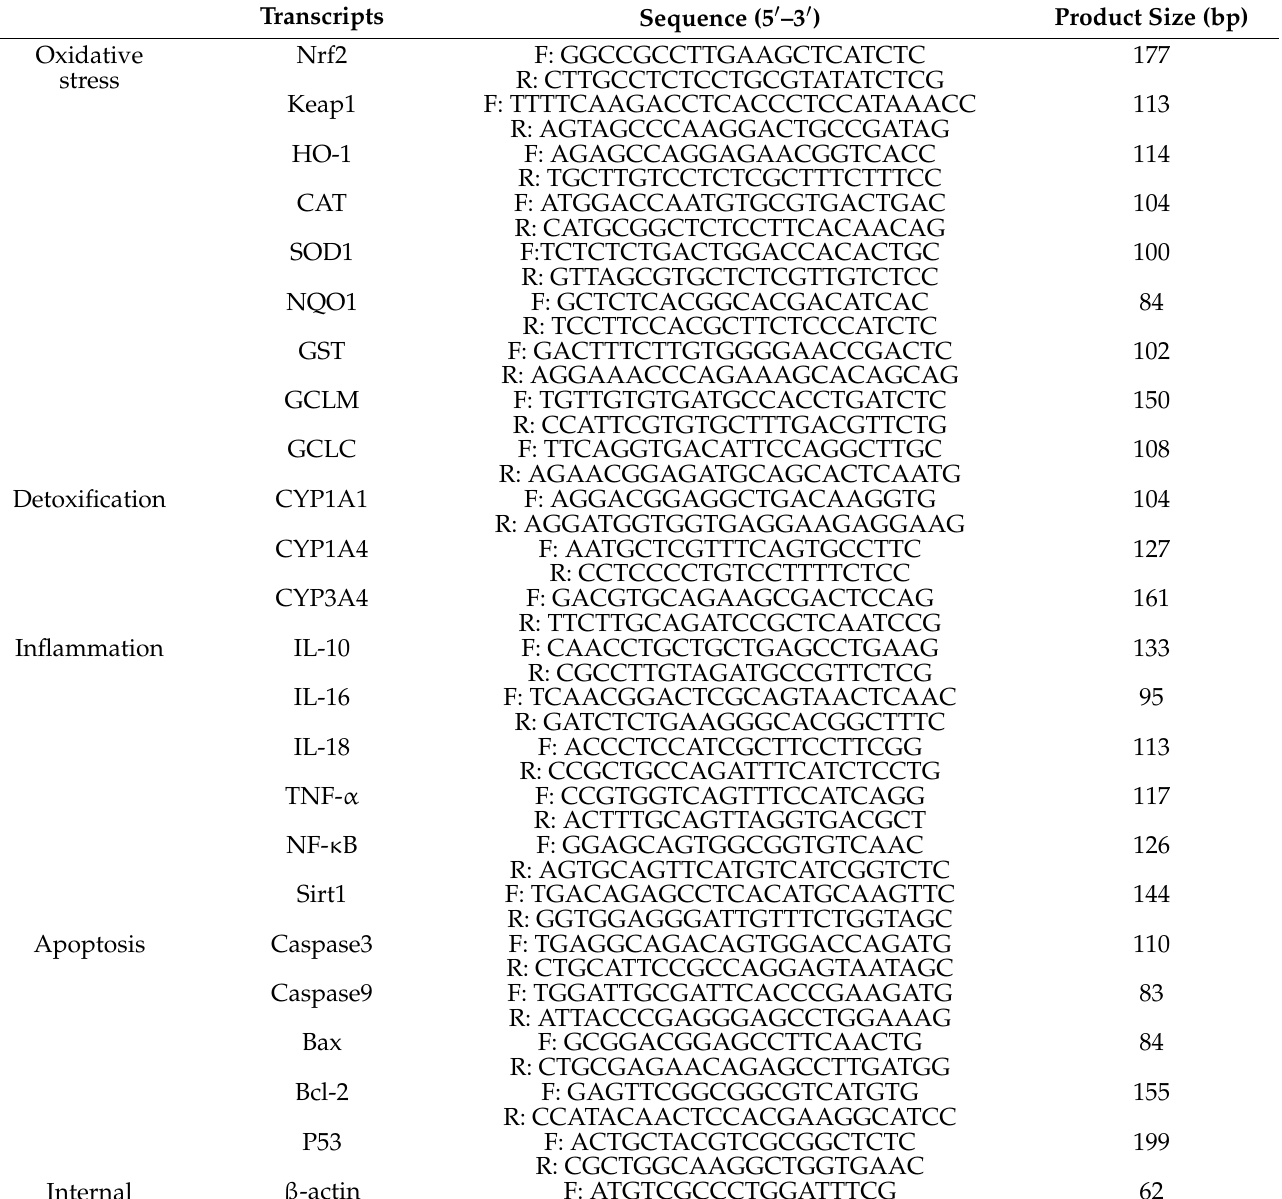
Table 2. Primer sequences and product lengths of target gene